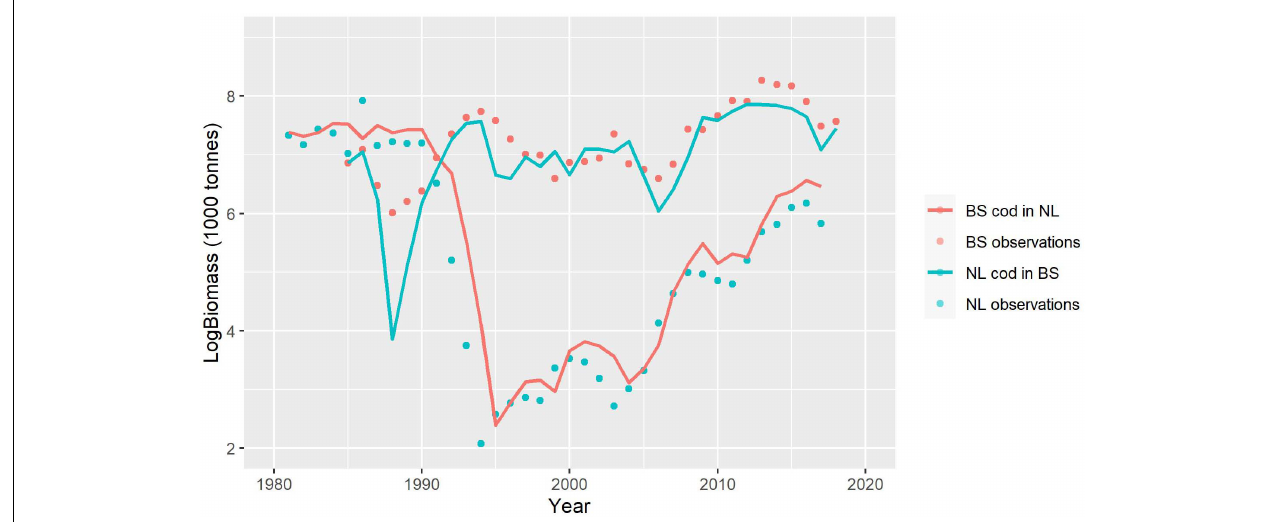
FIGURE 5 | Exploration of the thought experiment of transferring NL cod (blue line) into the Barents Sea (BS) ecosystem and BS cod (red line) into the Newfoundland-Labrador shelves (NL) ecosystem by switching intrinsic parameters ( T, Jmax, e , and a ) of the corresponding models between areas (see text for